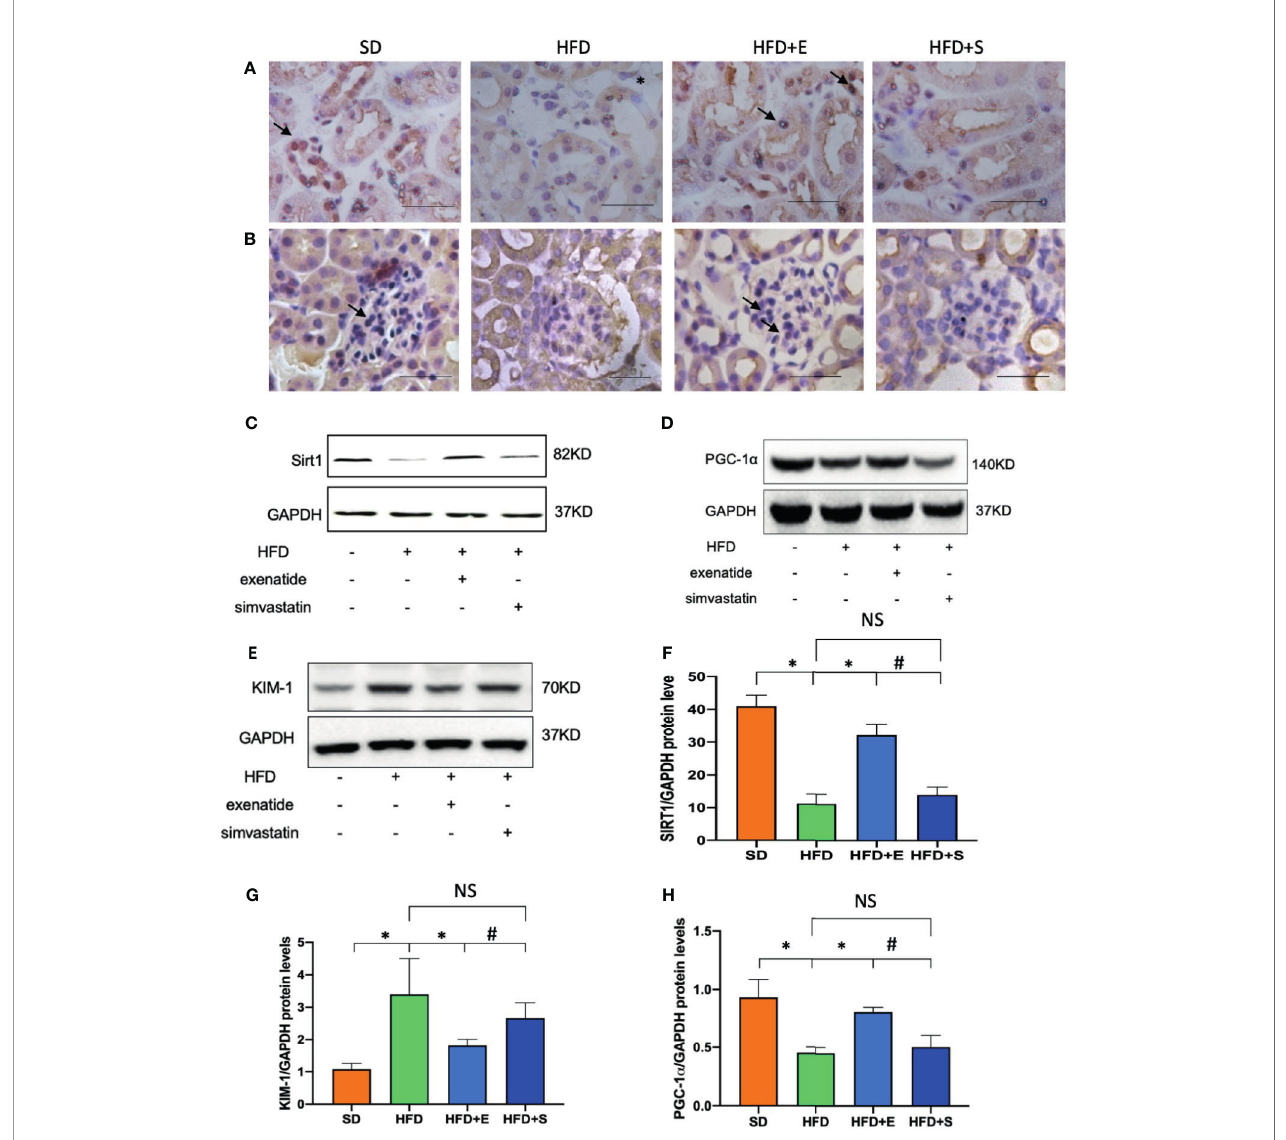
FIGURE 3 | Exenatide restored HFD-repressed SIRT1 expression in mice. (A, B) Immunohistochemistry analysis of SIRT1 expression in kidney tissue (original image magni fi cation: × 200, bars= 100 m m). (C) Western blots of SIRT1 in renal lysates. (D) Western blots of PGC-1 a in renal lysates. (E) Western blots of KIM-1 in renal lysates. (F – H) Relative protein expression of SIRT1, PGC-1 a , KIM-1. GAPDH was used as a control for protein loading. Data are presented as the mean ± SD (n=3). * P < 0.01 versus HFD group. # p < 0.01 versus HFD+E group. NS no statistical difference between